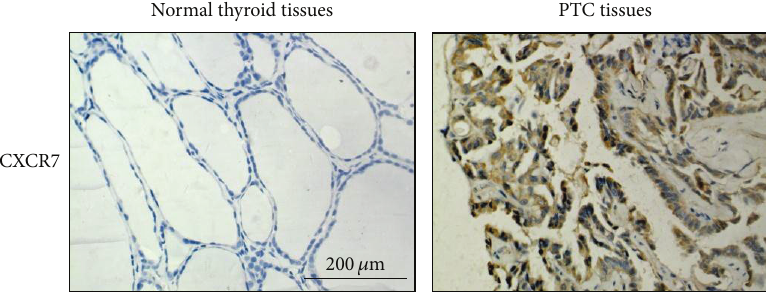
Figure 5: Increased expression of CXCR7 in PTC tissues. Representative examples of immunohistochemical staining of CXCR7 in normal thyroid tissues and PTC tissues (original magnification 400 × ). Representative results are